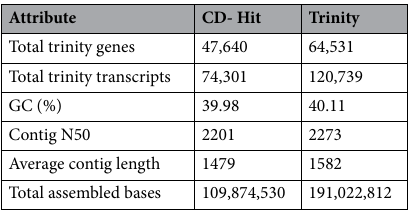
Table 1. Trinity assembly stats report of assembled